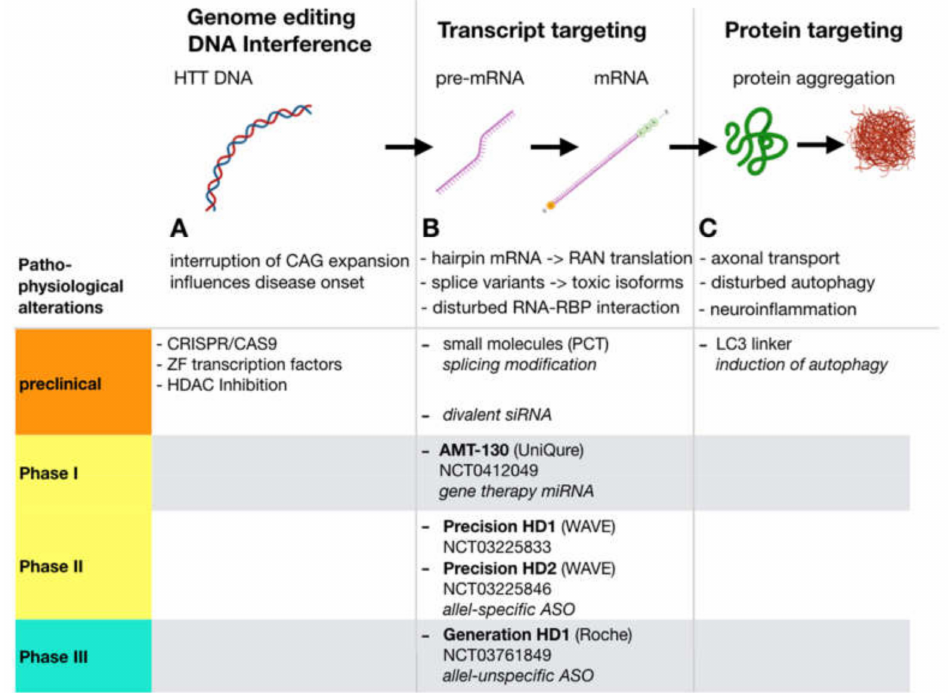
Figure 2. Huntingtin- lowering approaches: Along the process from htt DNA transcription via RNA processing and translation to protein folding and function, several well-defined points of interference are possible that ultimately result in lower levels of total or mutated htt protein. Strategies that aim at the protein level (C), i.e., by means of induction of autophagy rely on the hypothesis that HD is mainly a proteinopathy that results from disturbed function and neurotoxic accumulation of mutant htt protein. In contrast, gene expression modification strategies (B) inhibit the generation of the protein, but also may be suitable to cover pathologic aspects on the RNA level that may significantly contribute to HD pathogenesis. (A) Genome editing via, i.e., CRISPR / Cas9 may permanently correct mutant HTT . Correction of the CAG Repeat expansion may have additional beneficial e ff ects since the length of the uninterrupted CAG repeat length on DNA level is inversely correlated to disease onset (for references see text). Altering metagenomic structure by HDAC inhibition, or using Zink Finger transcription factors can inhibit transcription of mutant DNA to mRNA. PCT: PTC Therapeutics; LC3: autophagosome protein microtubule-associated protein 1A / 1B light chain